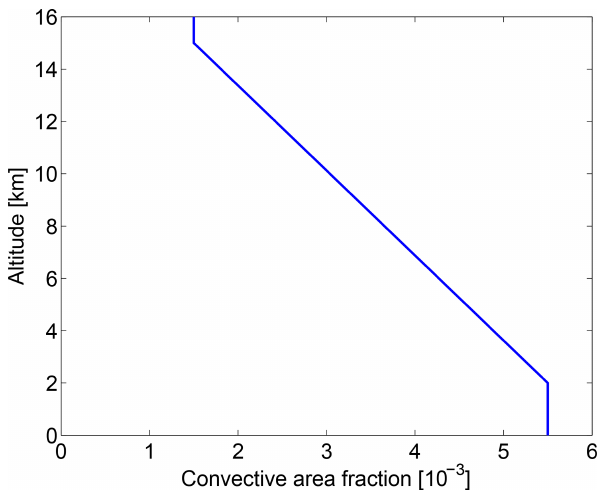
Figure 3. Constant convective area fraction profile used for calcu- lating vertical updraft velocities.